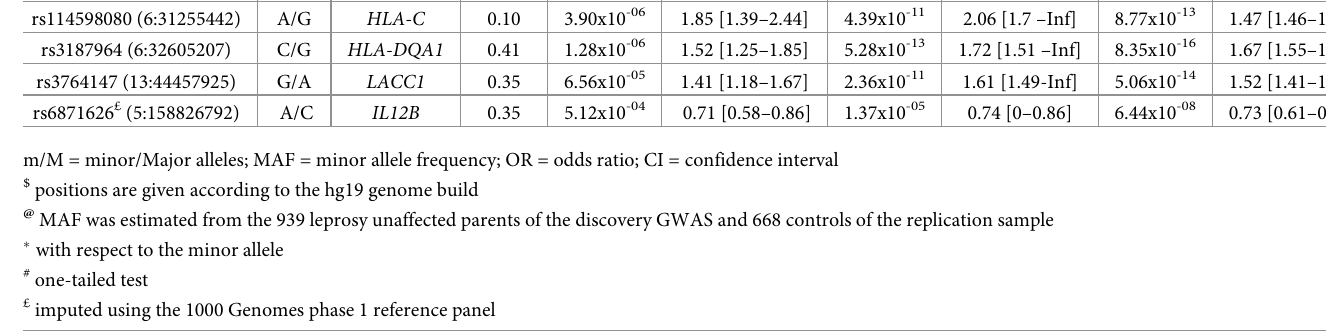
second replicated hit, rs6871626, is located on chromosome 5, 69 kb 5’ to IL12B . A borderline non-significant genome-wide p -value of 6.4x10 -8 was obtained for this SNP, with an OR of developing leprosy for AC vs. AA (or CC vs. AC) of 0.73 [0.61–0.84]. This SNP is not part of the 1000 Genomes phase 3 reference panel and no LD information was available for the KHV population, but it was successfully sequenced in the genome part of The Genome Aggregation Database (gnomAD) [37].